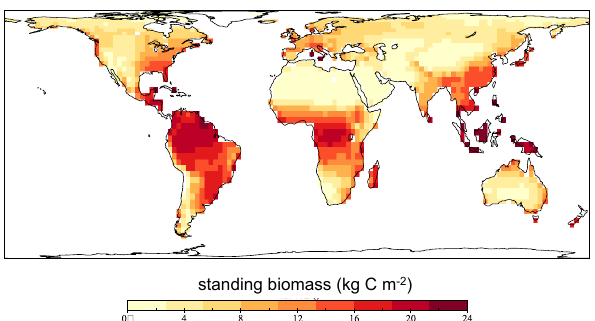
Figure 7. Carbon in terrestrial vegetation biomass of the control run. In this scenario the vegetation growth is constrained only by water, light, and temperature so that vegetation biomass reaches its maximum everywhere around the globe, while not accounting for P limitation. In this simulation biomass reaches 24kgCm − 2 in some tropical